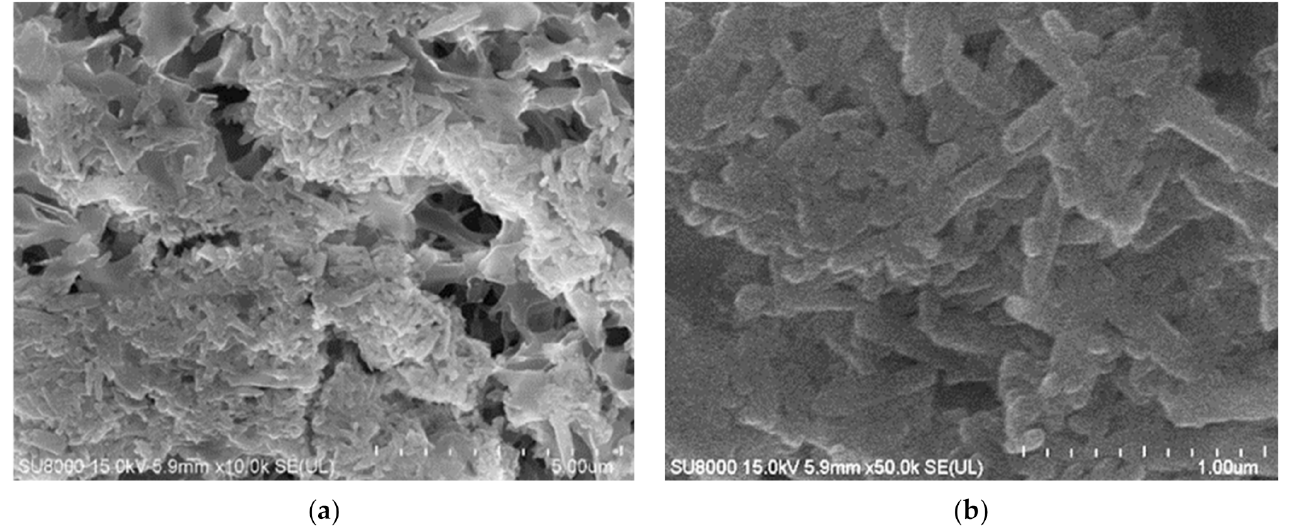
Figure 12. SEM images of: ( a ) Membrane surface covered by deposit formed during desalination process of the Baltic Seawater; ( b ) Deposit layer magnify × 50 k. Module